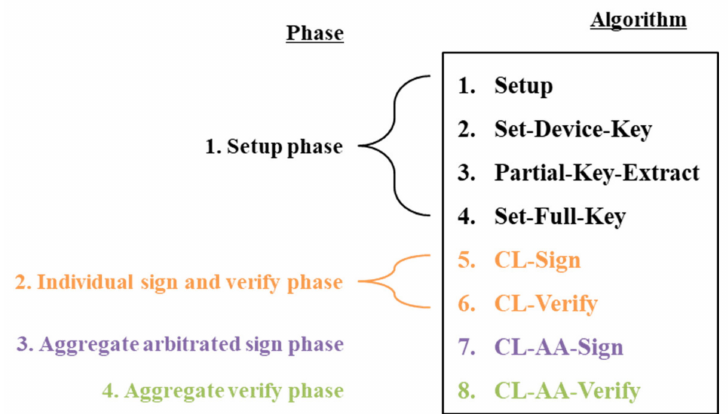
Figure4. Therelationshipbetweenthephasesandalgorithmsoftheproposedscheme. CL:certificateless, AA: aggregate